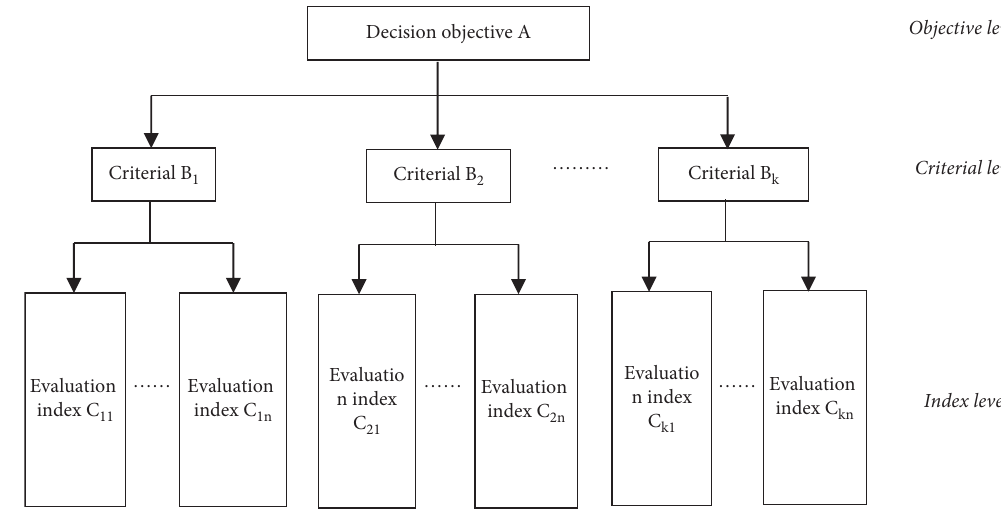
Figure 1: The hierarchical structure for the multiple indices system.